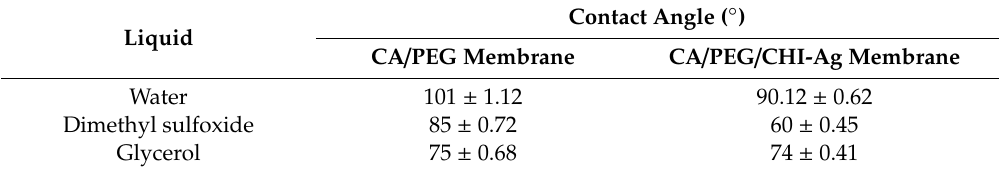
Table 1. Contact angle values of obtained polymeric membranes using di ff erent